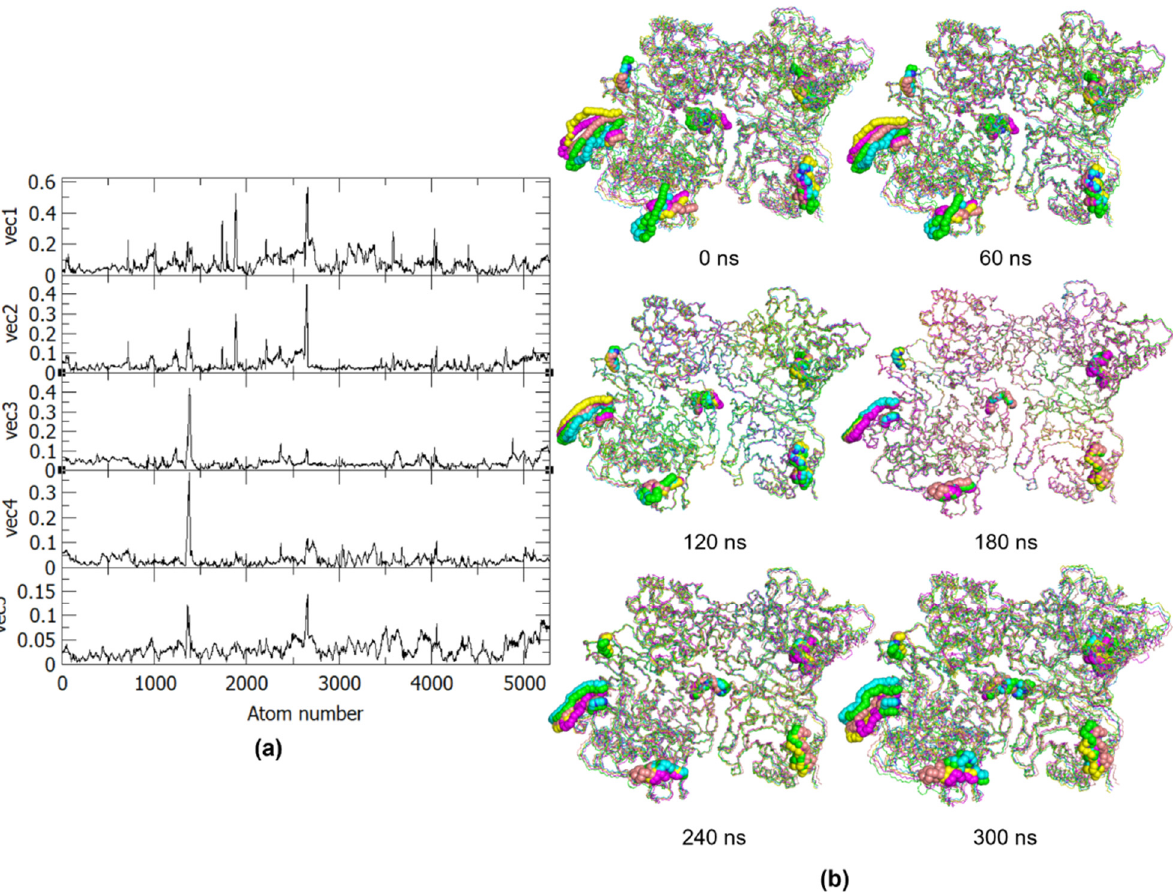
Figure 4. ( a ) RMSF of the first five eigenvectors from PCA and ( b ) Frames from the 300 ns trajectory for every 60 ns. The residues with essential motions are represented in spheres and the five principal components projections are colored as follows: PC1, green; PC2, cyan; PC3, magenta; PC4, yellow; PC5, pink.